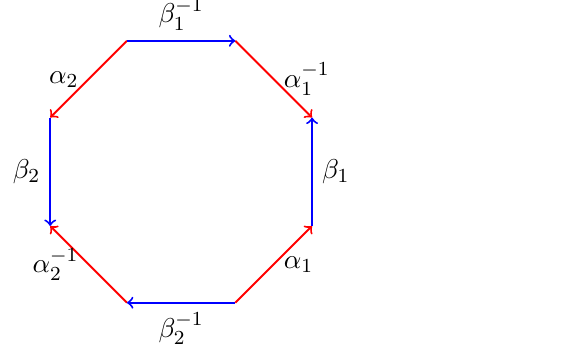
Figure 3 . The construction of a Riemann surface by gluing, here drawn for the example g =